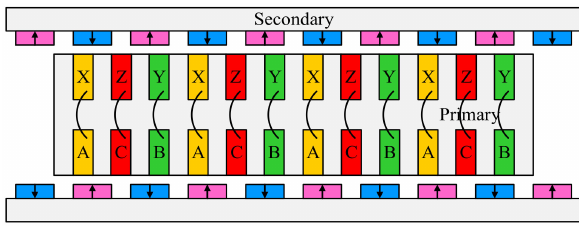
Figure 1. Structure of the 120 ◦ -TWDSPMLSM.